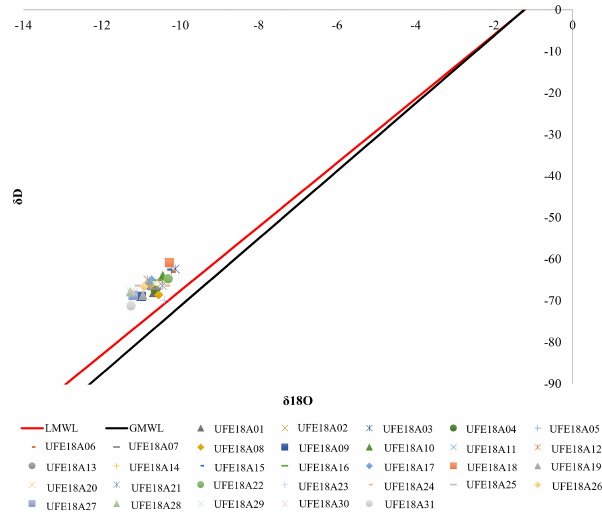
Figure 7. Isotopic composition of waters in the sampling col- lected. Meteoric water lines, global (GMWL – black line) and local (LMWL – red line), were also